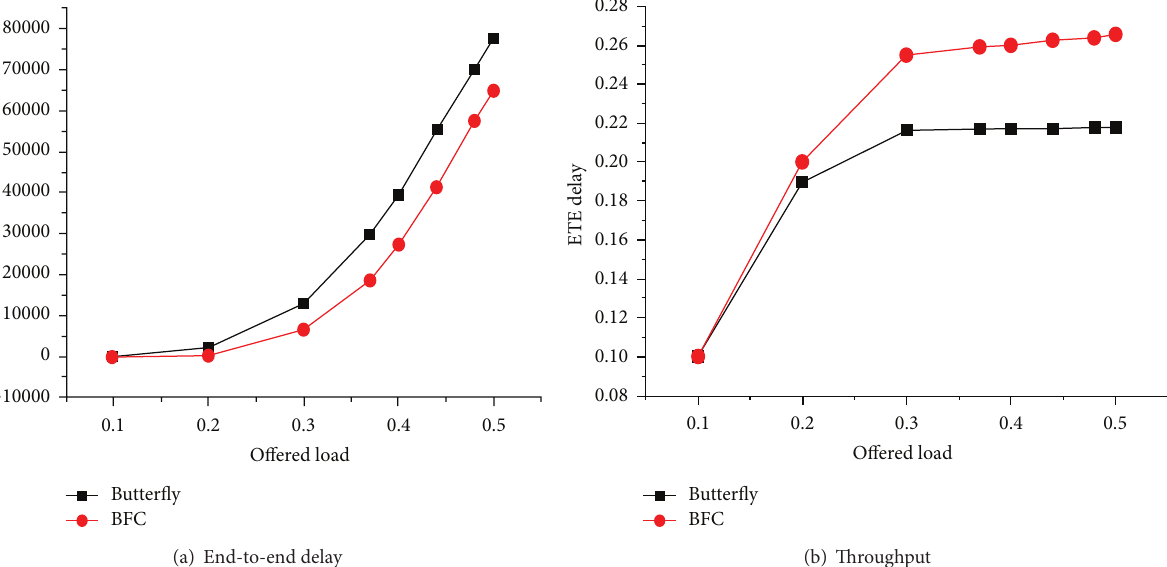
Figure 14: Performance comparison of two matrix flow models.